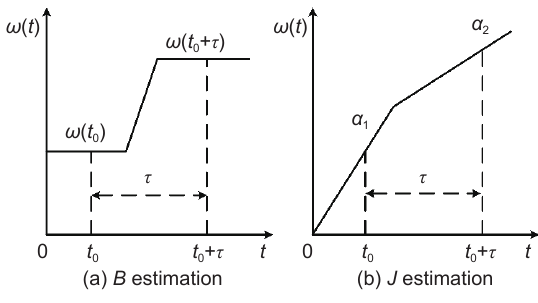
Fig. 5 Process of parameter